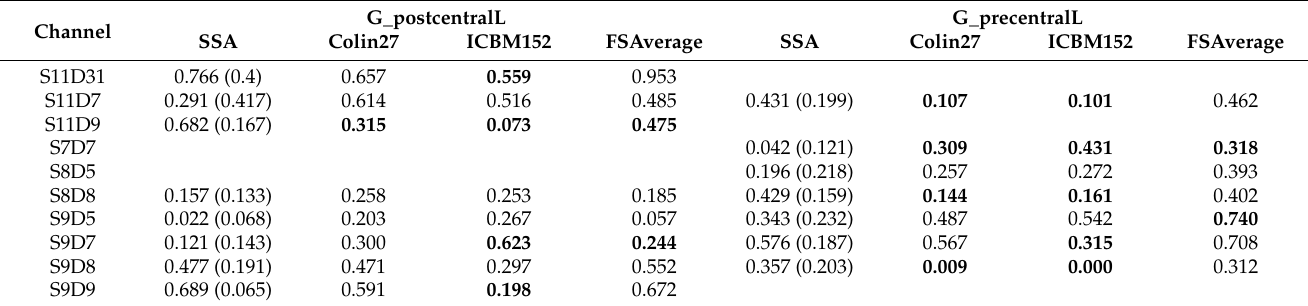
Table 6. Summary of A2Ch coefficients associated with left hemisphere Destrieux postcentral and precentral gyri. Results are reported for wavelength λ = 760 nm. Bold ABA values indicate channels presenting a 20% difference in A2Ch coefficients from the SSA median.